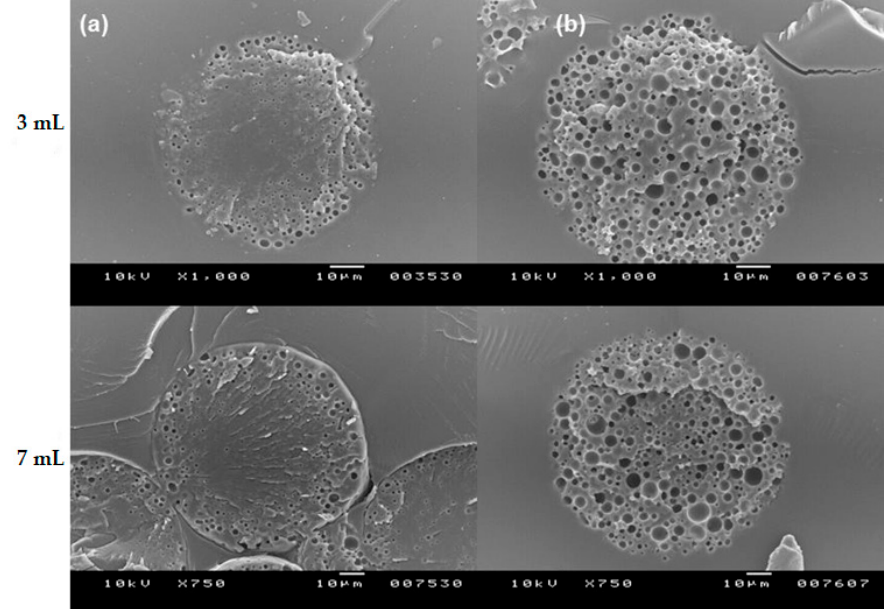
Figure 12. SEM images of the internal morphology of dried PLGA microspheres after self-healing (bar size = 10 µm). Dried microspheres prepared using 3 mL and 7 mL of the ammonia solution were first incubated at RT for ( a ) 2 h and ( b ) 24 h and were followed by self-healing.